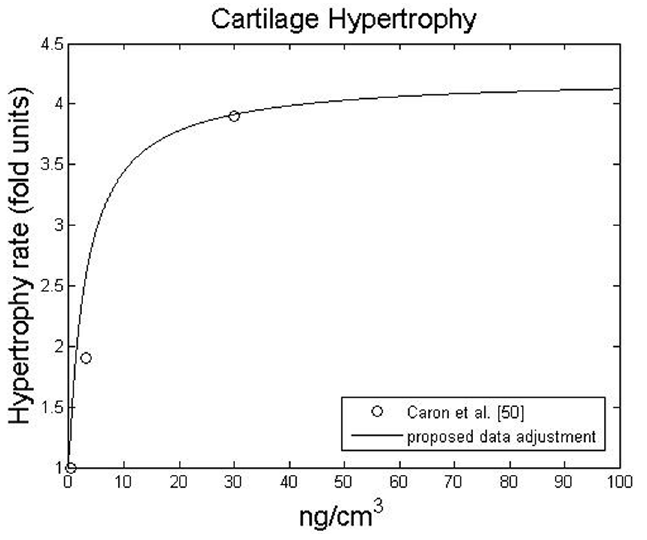
Fig 3. Influence of BMP-2 on chondrocyte hypertrophy. Chondrocyte hypertrophy is expressed as a fold increase relative to chondrocyte hypertrophy without